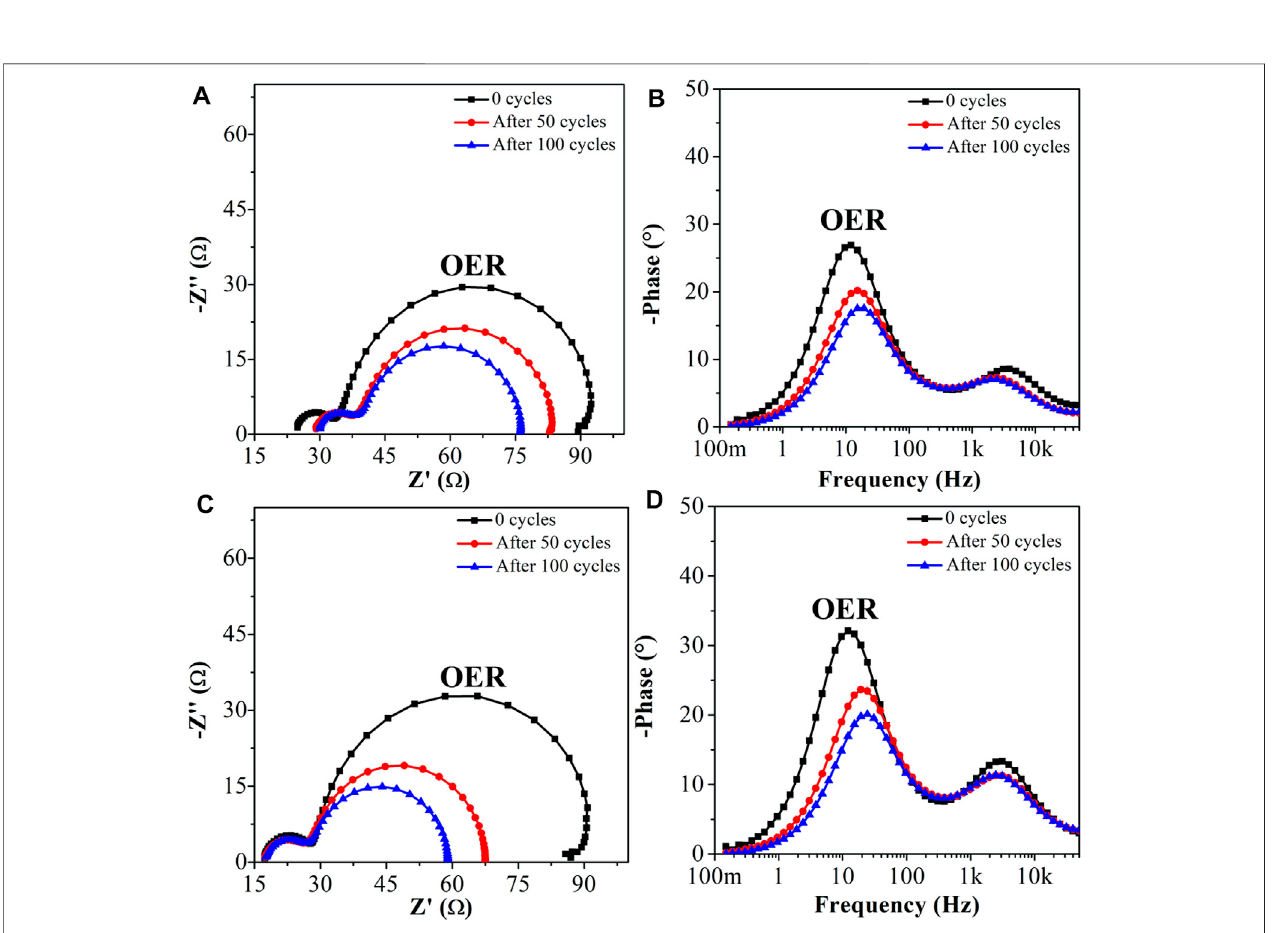
FIGURE5|(A,C) Nyquist and (B,D) Bodephaseplotsof α -Ni(OH) 2 (A,B) andNi 0.9 V 0.05 Ce 0.05 -LDH (C,D) aftersuccessiveCVs.EISmeasurementswerecarried out at 0.5 V DC potential, AC signal (cid:2) 10 mV, frequency range (cid:2) 0.1 – 50,000 Hz range.